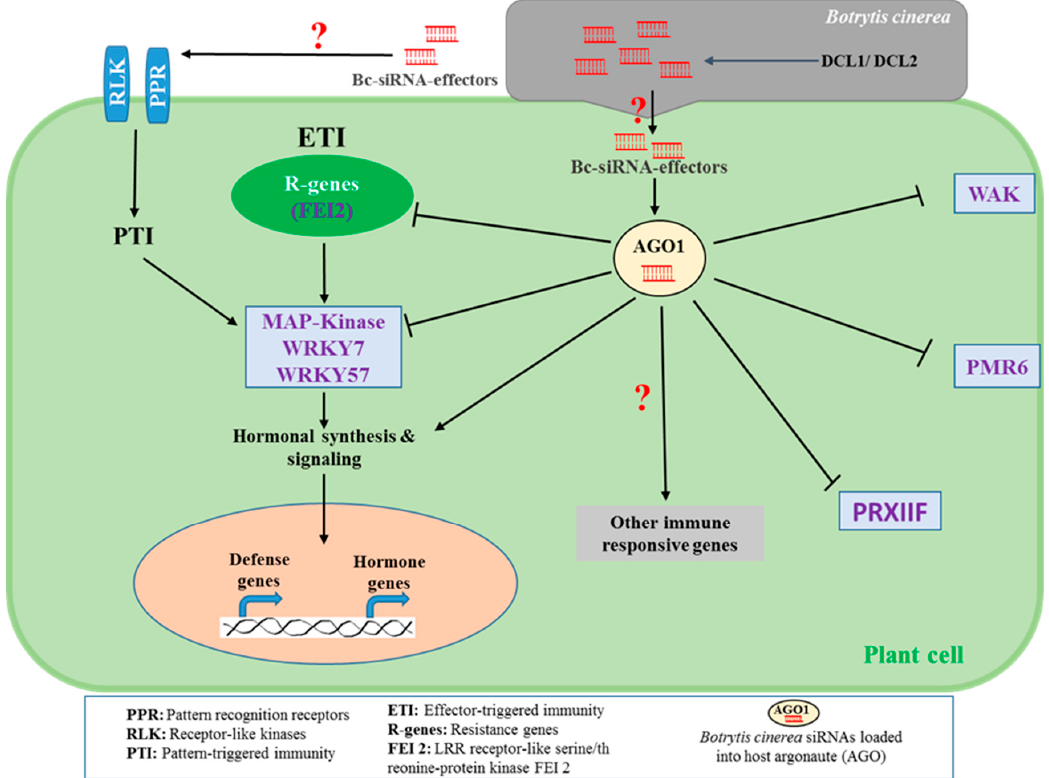
Figure 1. Botrytis cinerea ’s small RNA (sRNA) effectors modulate the plant immune system to induce the gray mold disease. B. cinerea synthesize small interfering RNA (siRNA) effectors by Dicer-like 1 and 2 proteins (DCL1 and DCL2) and deliver them to host plant cells to interfere with the host RNAi machinery (argonaute; AGO1) and subsequently silence and suppress the plant defensive factors, including leucin rich repeat (LRR) receptor-like serine / threonine-protein kinase FEI 2 , mitogen-activated protein kinases ( MAP-kinase ), WRKY7 , WRKY57 , cell wall-associated kinase (e.g., WAK ), pectinlyase (e.g., PMR6 ), and peroxiredoxin (e.g., PRXIIF ). The mechanisms by which Bc -siRNA interfere with the plant immunity systems (e.g., PTI and ETI), hormonal biosynthesis and signaling as well as immune responsive genes have been perceived but are not fully